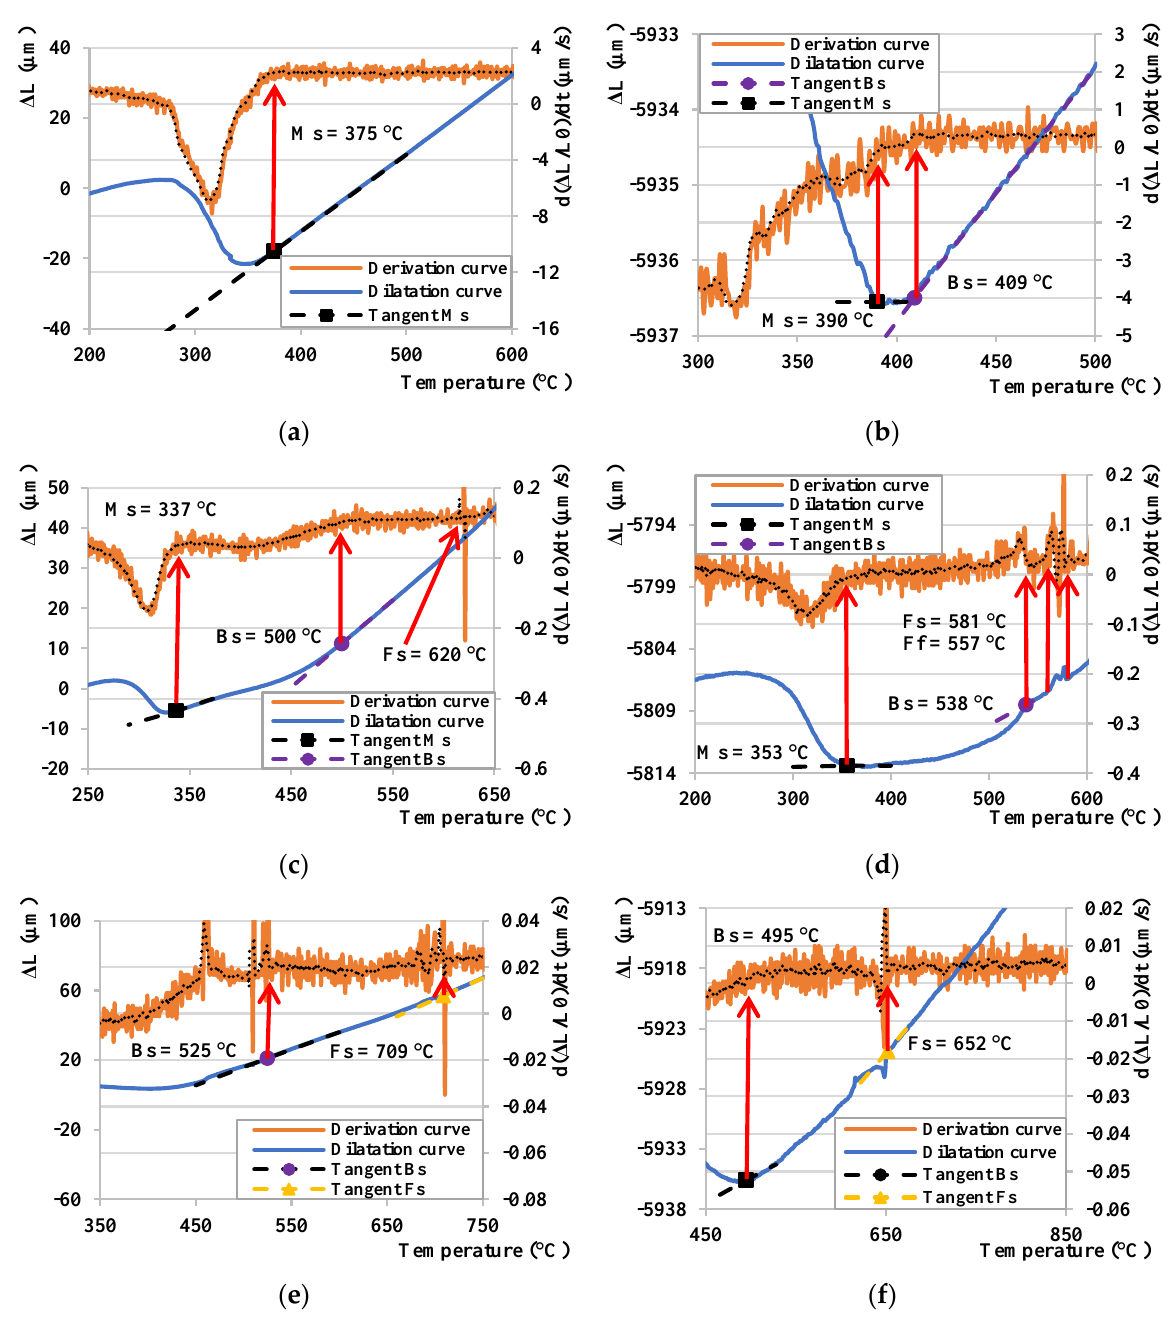
Figure 7. Comparison of dilatation curves for a cooling mode: ( a ) CCT 10 °C/s, ( b ) DCCT 10 °C/s, ( c ) CCT 0.5 °C/, ( d ) DCCT 0.5 °C/s, ( e ) CCT 0.05 °C/s, ( f ) DCCT 0.05 °C/s.